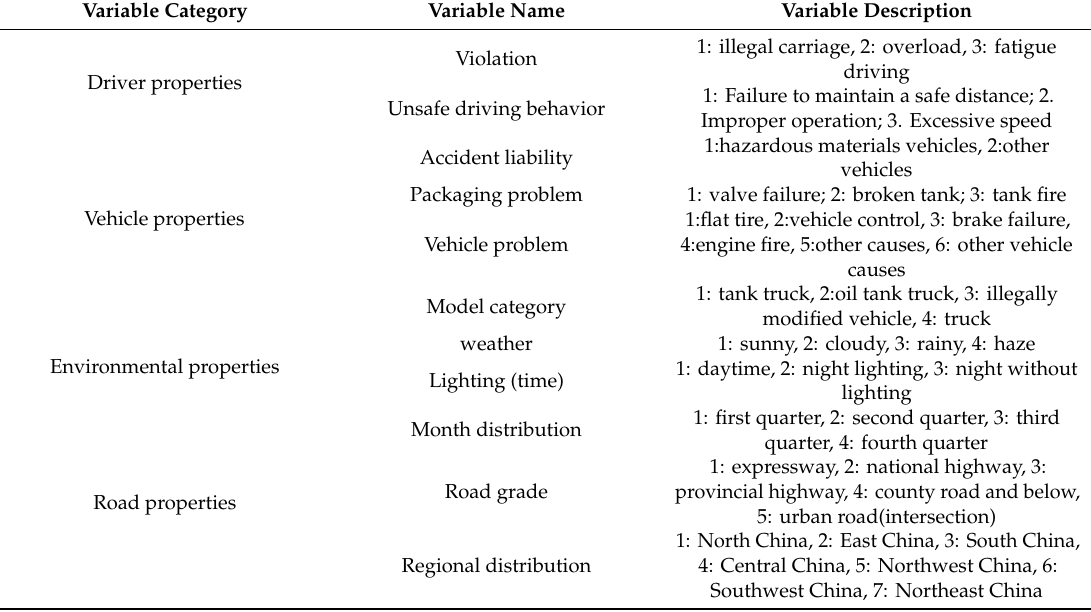
Table 1. Independent variables of severity of hazardous materials transportation